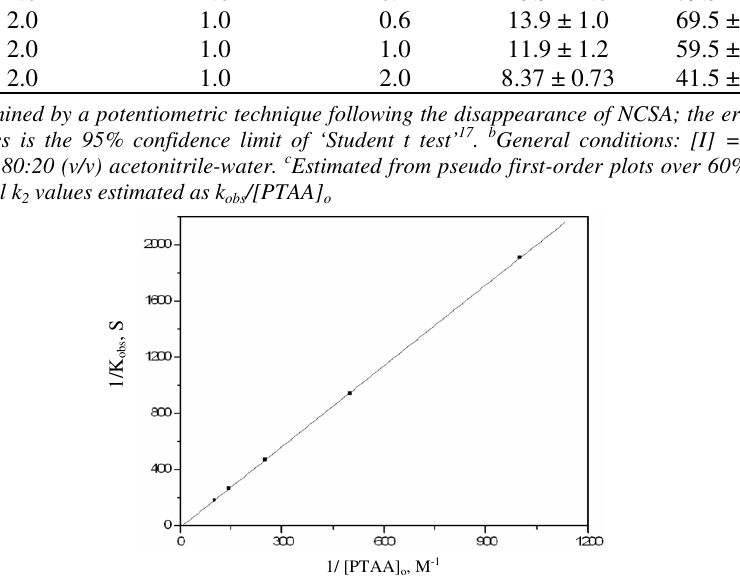
Figure 1. Double reciprocal plot for the oxidation of PTAA with